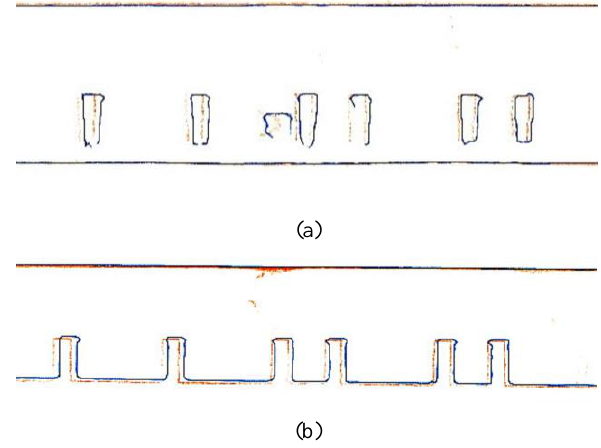
Figure 15. Details of sections with scale factor corrected: